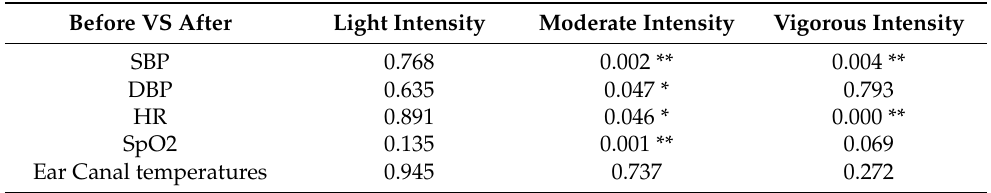
Table 9. Significance coefficients for paired-sample t -tests of physiological parameters before and after horticultural